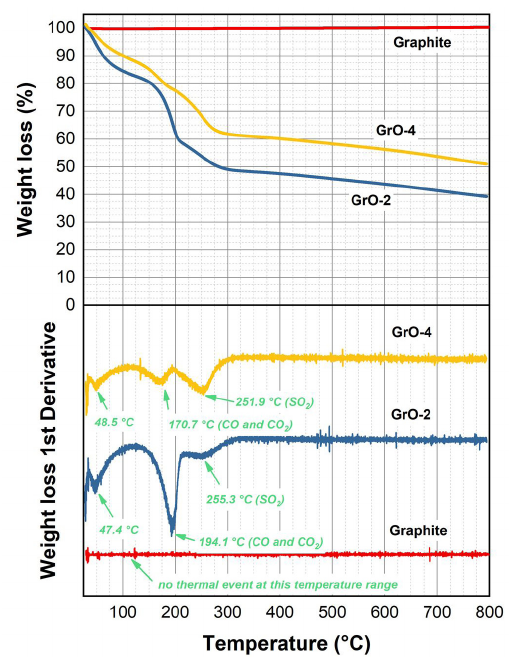
Figure 2. Thermogravimetric analysis for graphite powder, GrO-2, and GrO-4, under an N atmosphere (a) and mass loss events from 2 TGA derivative curves of the samples (b).